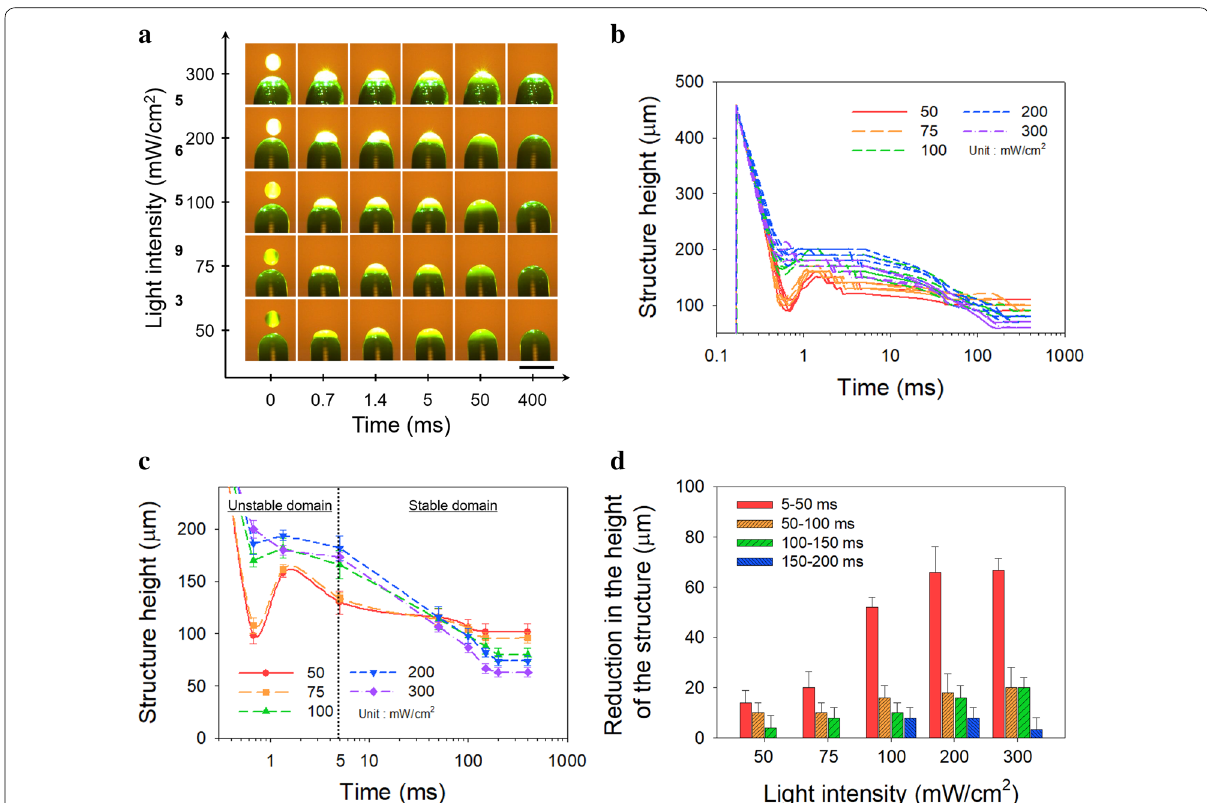
Fig. 3 The process of deposition of the photocurable droplet on the structure. a High speed images. b , c Changes occurring in the height of the structure. d The reduction in the height of the structure in accordance with the time period. The scale bar is 1